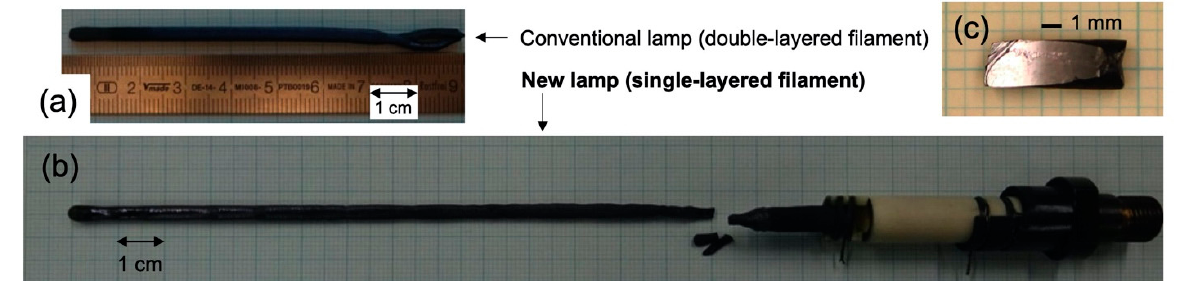
Figure 4. Photograph of the grown crystals using ( a ) conventional halogen lamps with double-layered filament and ( b ) new lamps with single-layered filament. ( c ) A photograph of the cleaved crystal. The shiny surface represents the (001) plane.